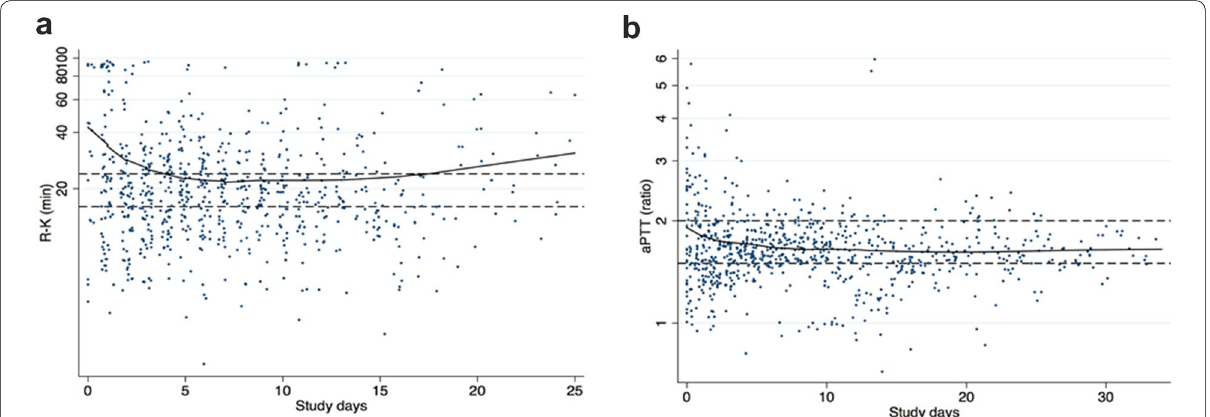
Fig. 3 aPTT ratio and R-K values during study days in patients randomized to the aPTT group (panel A) and to the TEG group (panel B). Lines are lowess smoothing. Reference lines: 1.5–2 for the aPTT ratio and 16–24 min for the R time. 56.5% of the analysis was in range in the aPTT group com- pared to 29.8% in the TEG group ( p < 0.001). aPTT activated partial thromboplastin time ratio, R-K TEG reaction time, TEG